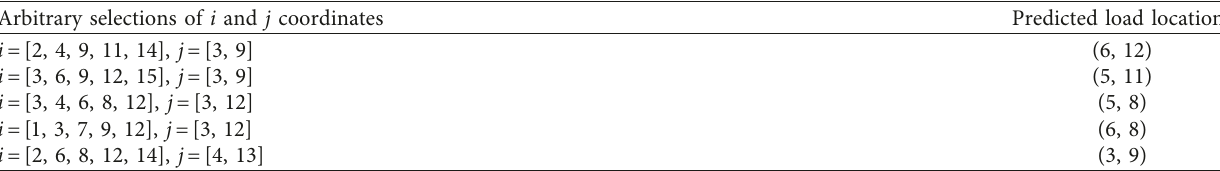
Table 2: Predicted load locations using arbitrary locations for sensor